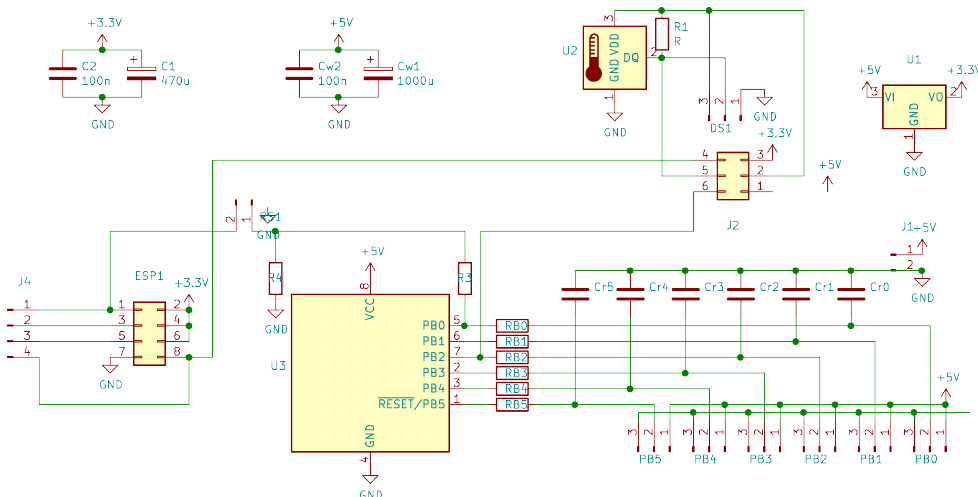
Figure 4. Schematic diagram of the universal measuring system applied in our research